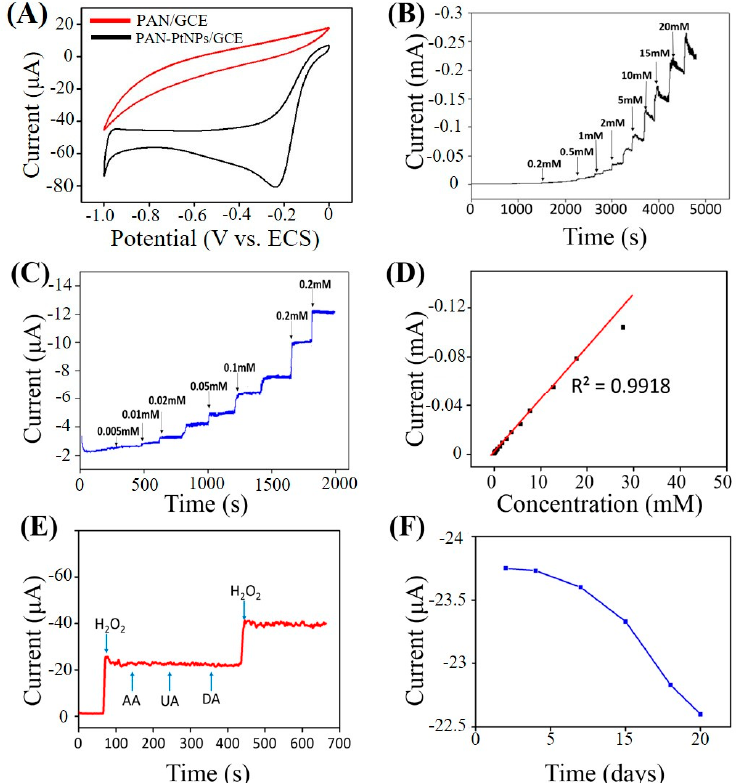
Figure 5. PAN–PtNPs/glassy carbon electrode (GCE) for sensing test (scan rate: 50 mV/s, PBS, PH = 7.4): ( A ) Typical cycle voltammetry (CV) curves of both PAN/GCE and PAN–PtNPs/GCE; ( B , C ) Current-time (I-T) response of PAN–PtNPs/GCE with different detection ranges; ( D ) Corresponding linear current-concentration relationship; ( E ) Selectivity; and ( F ) Stability.